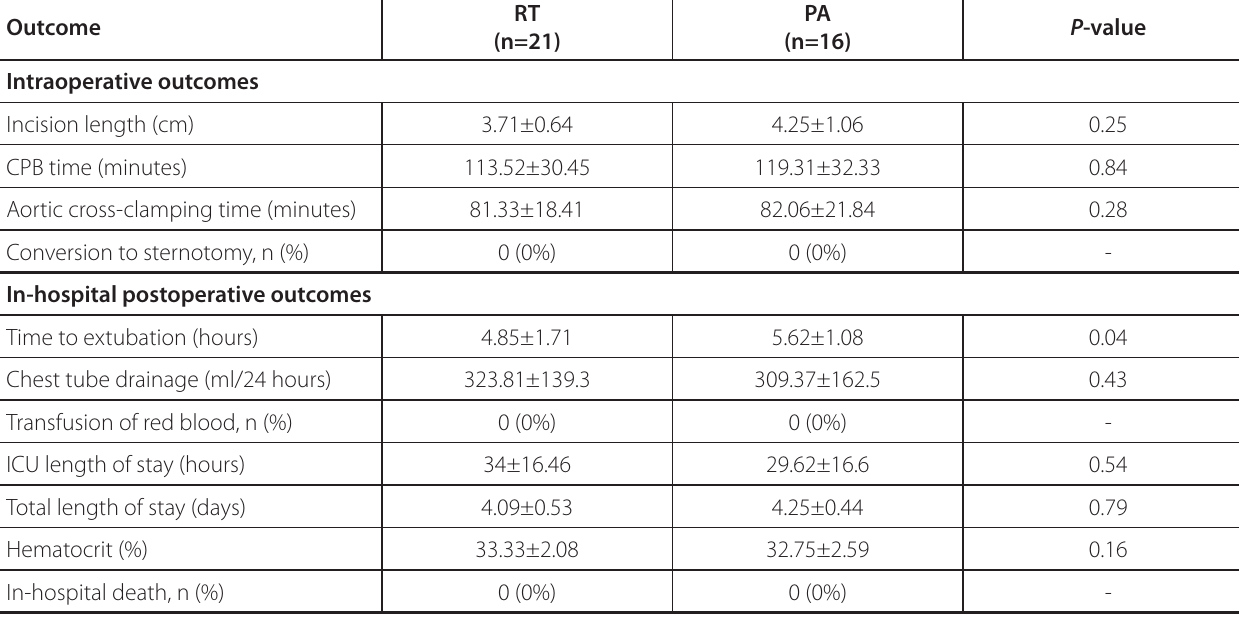
Table 2 . Intraoperative and in-hospital postoperative outcomes of patients who underwent MIS mitral valve repair via RT and PA.